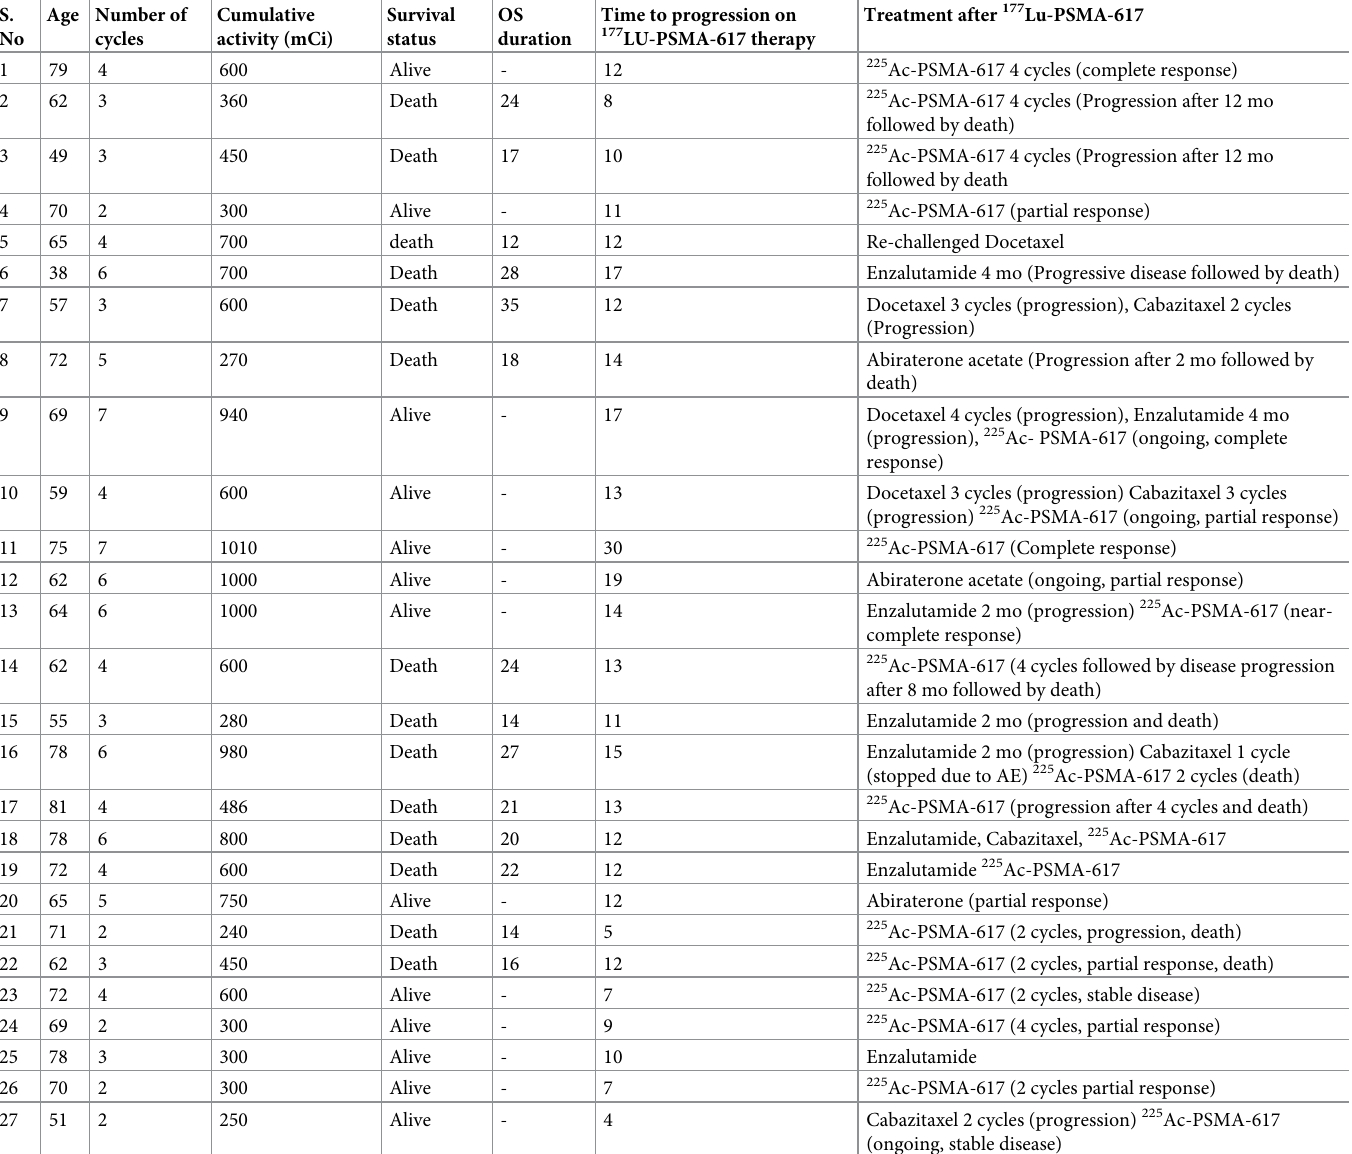
Table 4. Details of patients treated with alternate anti-cancer treatment options after 177 Lu-PSMA-617 RLT. S. Age Number of No